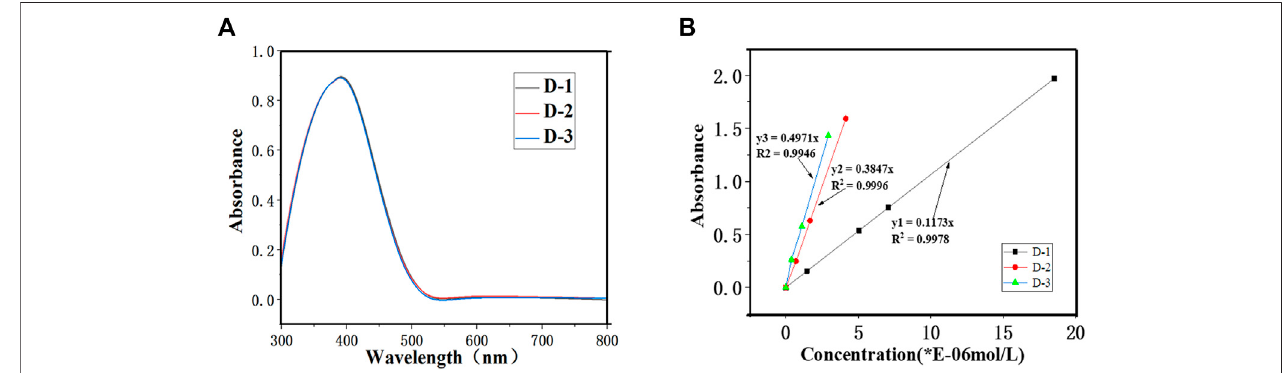
FIGURE 4 | Contact angle of water in oils on AF layer as a function of DC voltage. (A) D-1; (B) : D-2; (C) : D-3; Solvent: decane.